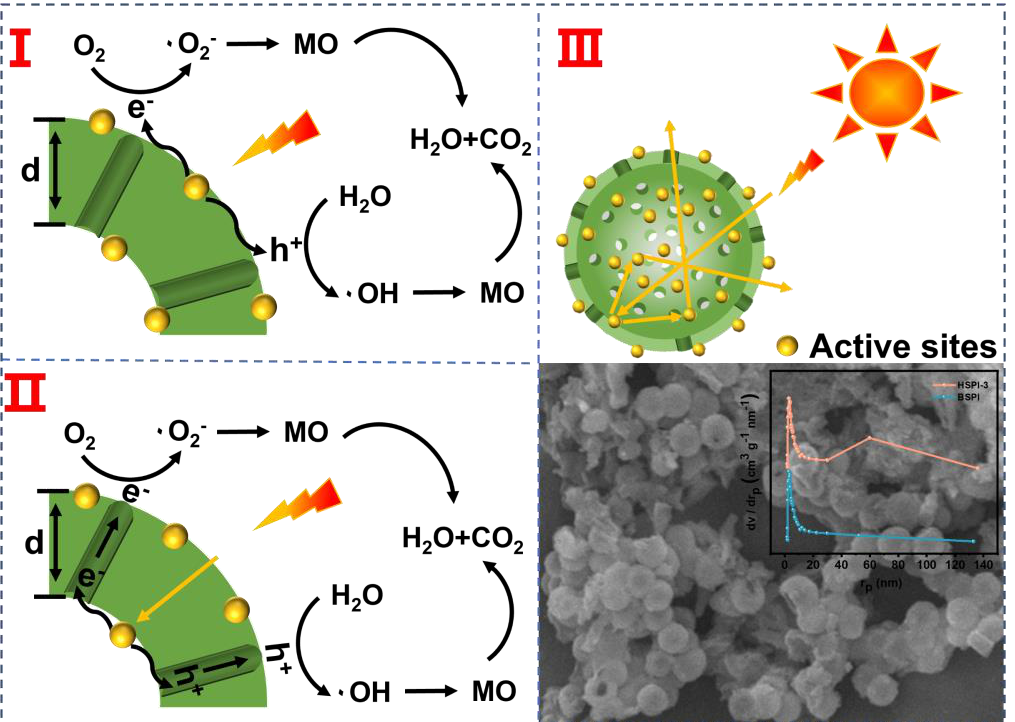
Figure 11. ( І–Ш ) Mechanism of photocatalytic degradation of MO by HSPI. Figure 11. ( I – III ) Mechanism of photocatalytic degradation of MO by